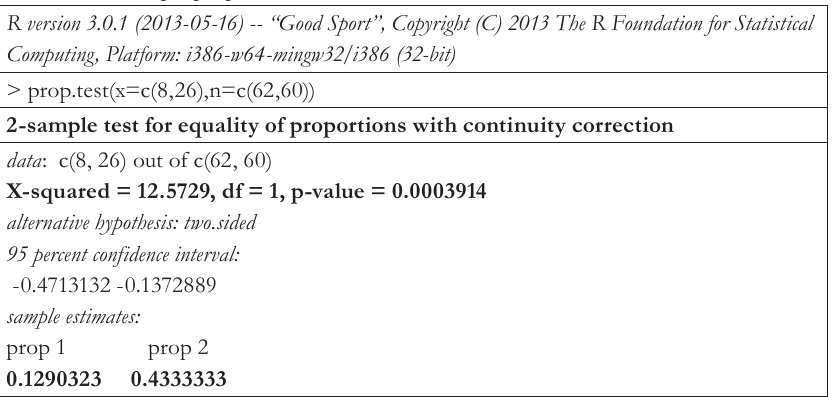
Tab. 3 – Two-sample proportion test. Source: Author´s own,